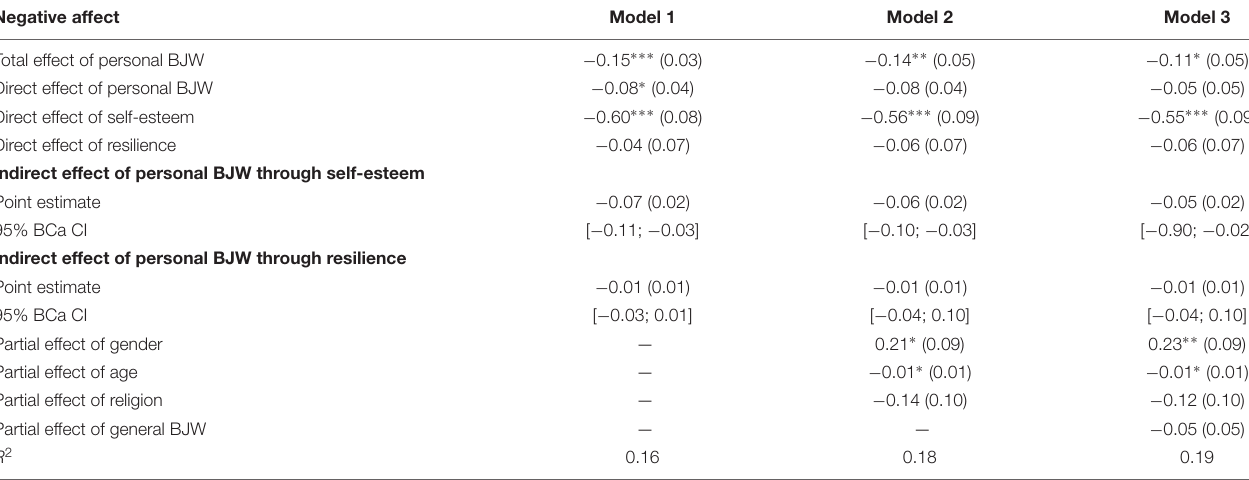
TABLE 4 | Results from bootstrap mediation analyses for negative affect ( N = 475).